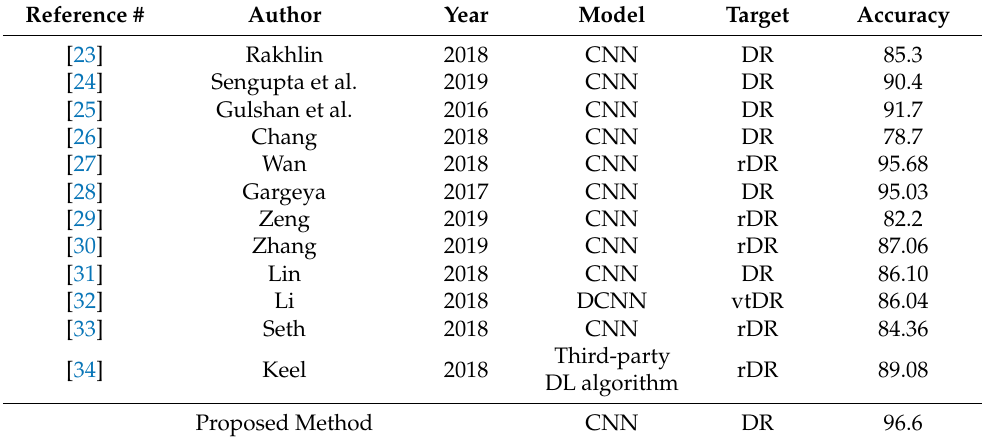
Table 9. Performance comparison of the proposed framework with baseline methods.